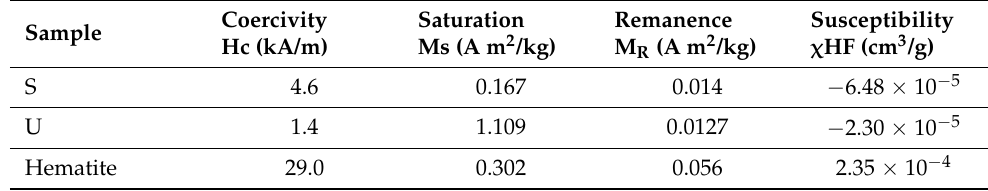
Table 2. Magnetic parameters of TPRs derived from hysteresis cycles at